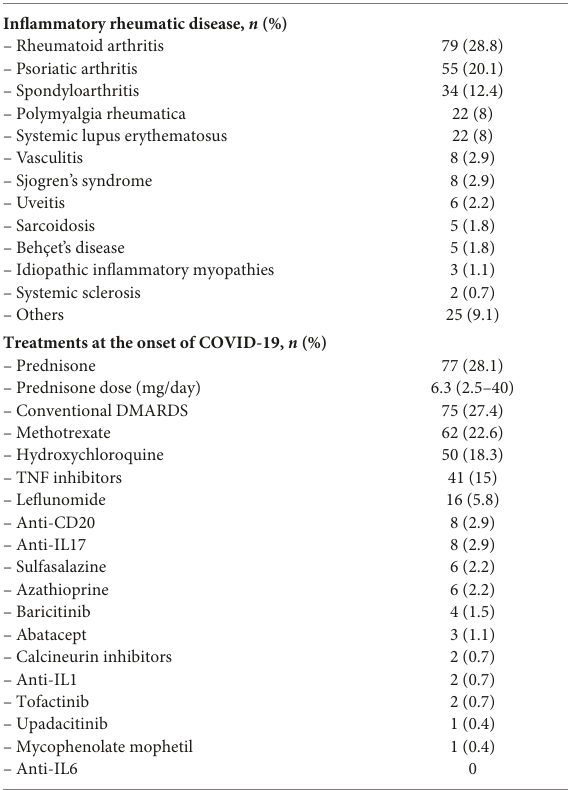
TABLE 2 Demographics, cardiovascular risk factors and comorbidities in coronavirus disease (COVID) patients with inflammatory rheumatology diseases versus